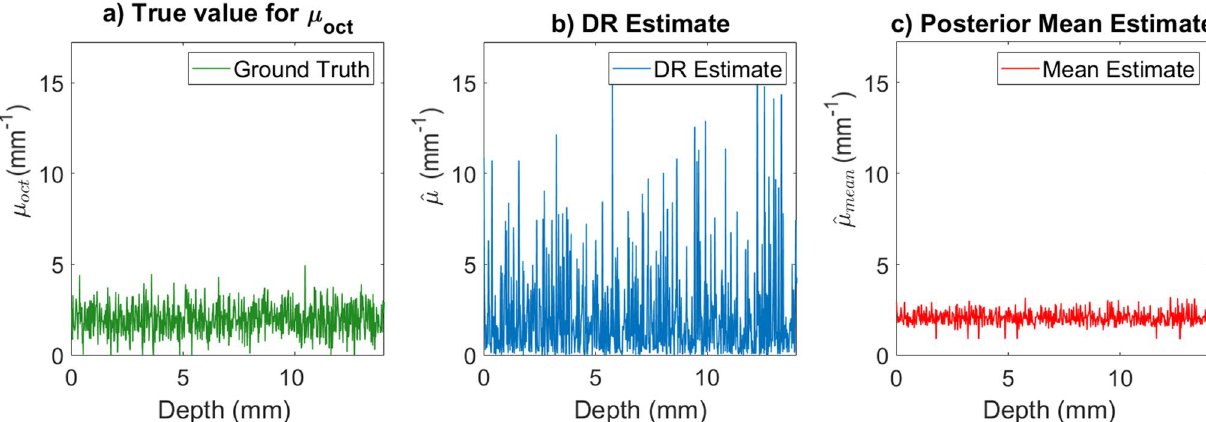
Figure 5. This figure shows estimates of the attenuation coefficient for simulated OCT data using the standard DR and the Bayesian estimator given in (26). The OCT data was simulated with parameters I inc 6 mm 2 1 10 2.00 β NA 0.3 , σ scat µ oct , a lateral resolution of (cid:31) x − = × = = domain which is 13.6 mm deep. After the attenuation coefficient was inferred using the DR method the bottom 30% of pixels are discarded to avoid reconstruction artifacts. Both the simulations and figure creation were